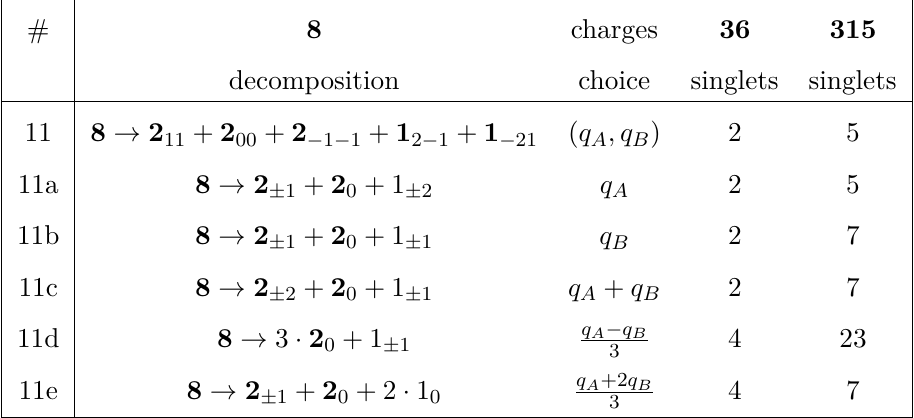
Table 4 . Branchings for the case